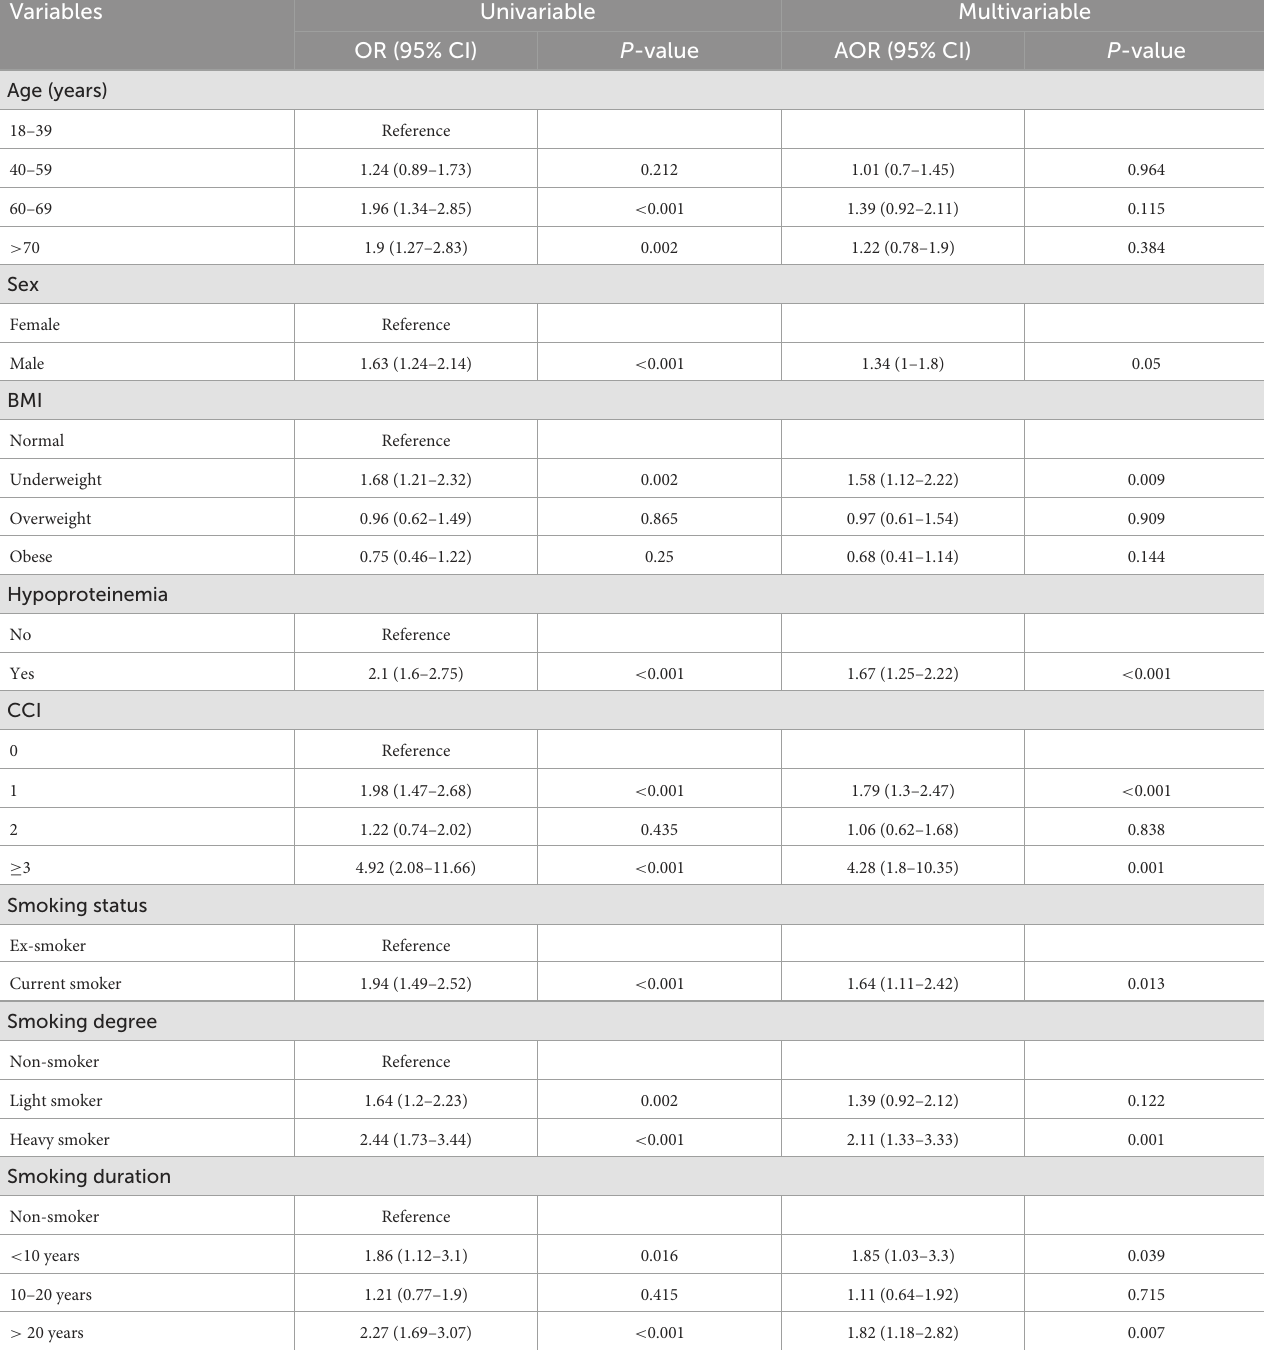
TABLE 4 Odds ratios (ORs) for transmission of PTB in smoking and associated factors.